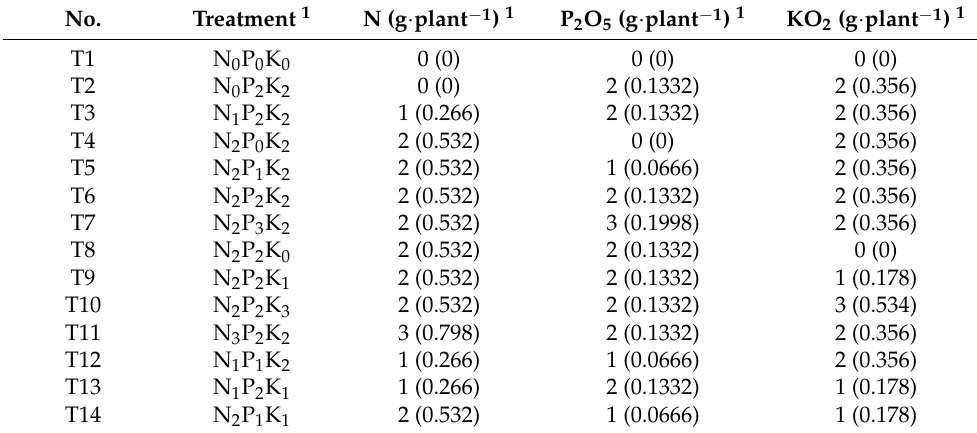
Table 1. Fertilizer rates used in the “3414” fertilization experiment (Reprinted from ref. [32].)